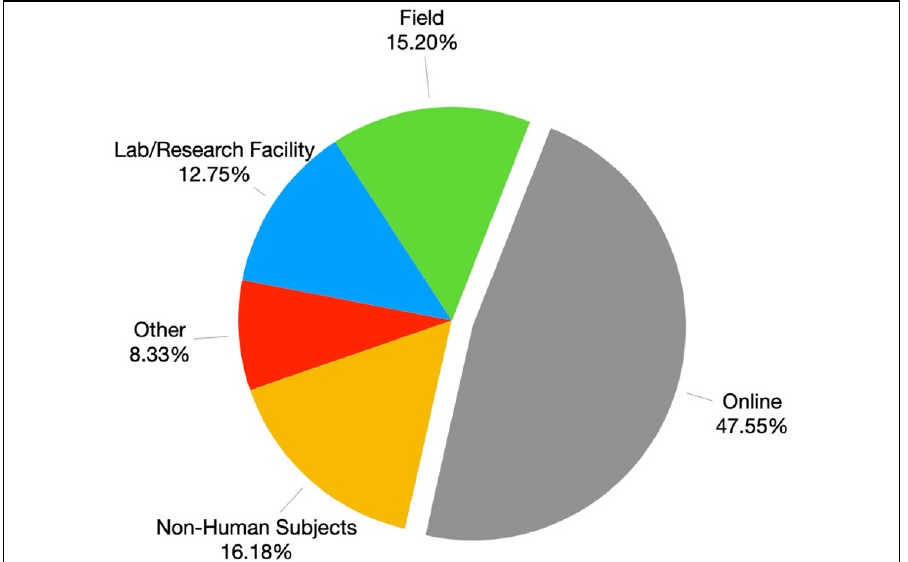
Figure 6. Distribution of research context.